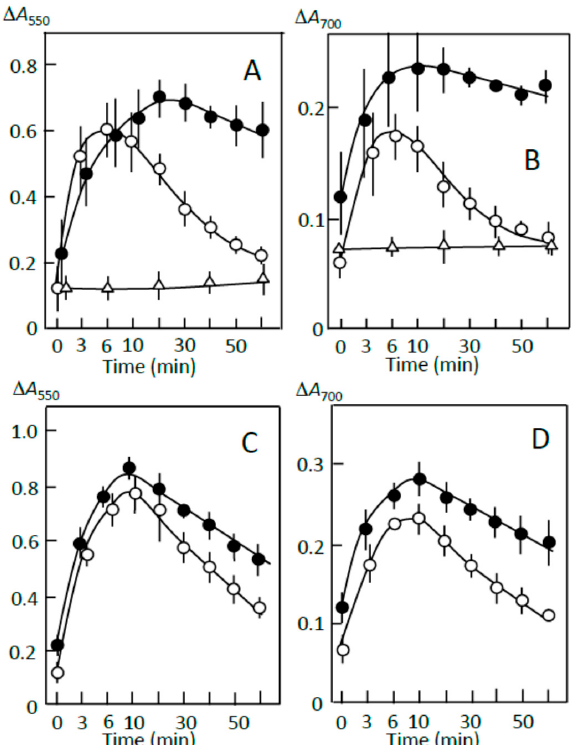
Figure 7. Starch digestion suppression by precipitates prepared using ( A , B ) adzuki extract and ( C , D ) fatty acid plus flavonoids. ( ○ ) sediment prepared from retrograding joshinko, ( ∆ ) precipitate